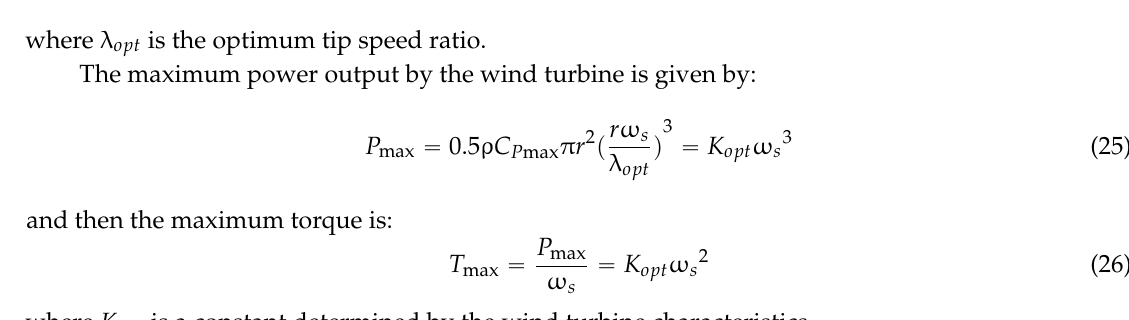
Figure 8a is mechanical power versus rotor angular speed curves calculated by Equation (25). Figure 8b is mechanical torque versus rotor angular speed curves calculated by Equation (26).